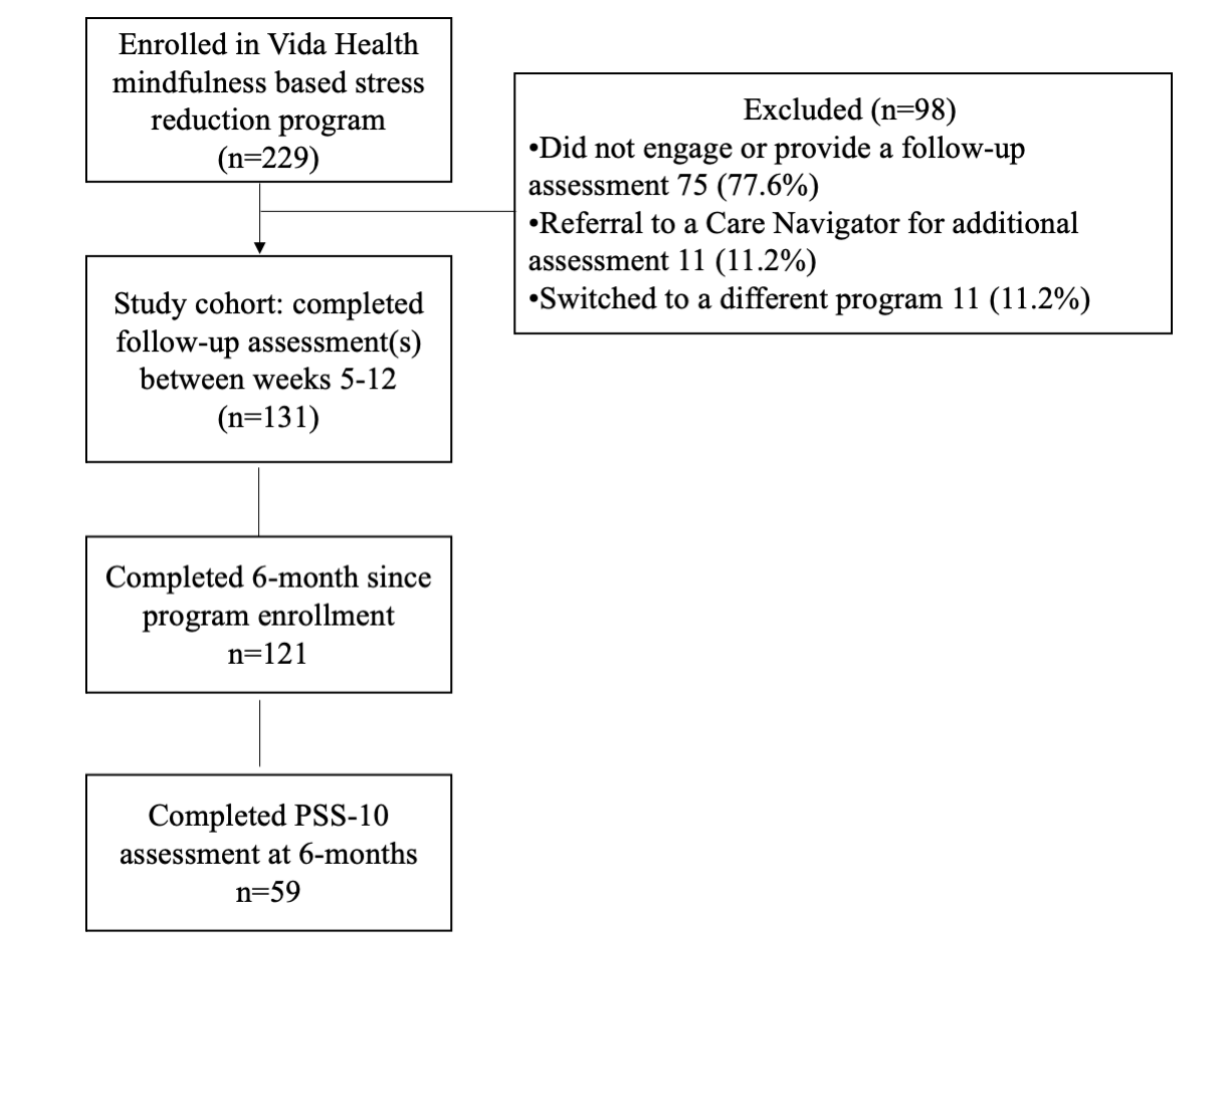
Figure 4. A schematic of participant flow. PSS: Perceived Stress